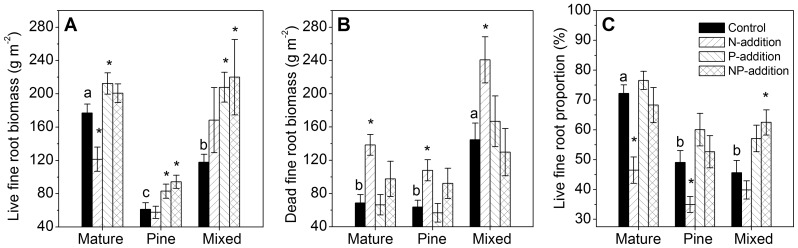
Live, dead fine root biomass and live fine root proportion after five years of nitrogen and phosphorus additions.Data from July 2012. Different letters indicate significant differences among forests (P<0.05). * indicates significant differences between each treatment and control (P<0.05). Error bars show SE (n = 5).